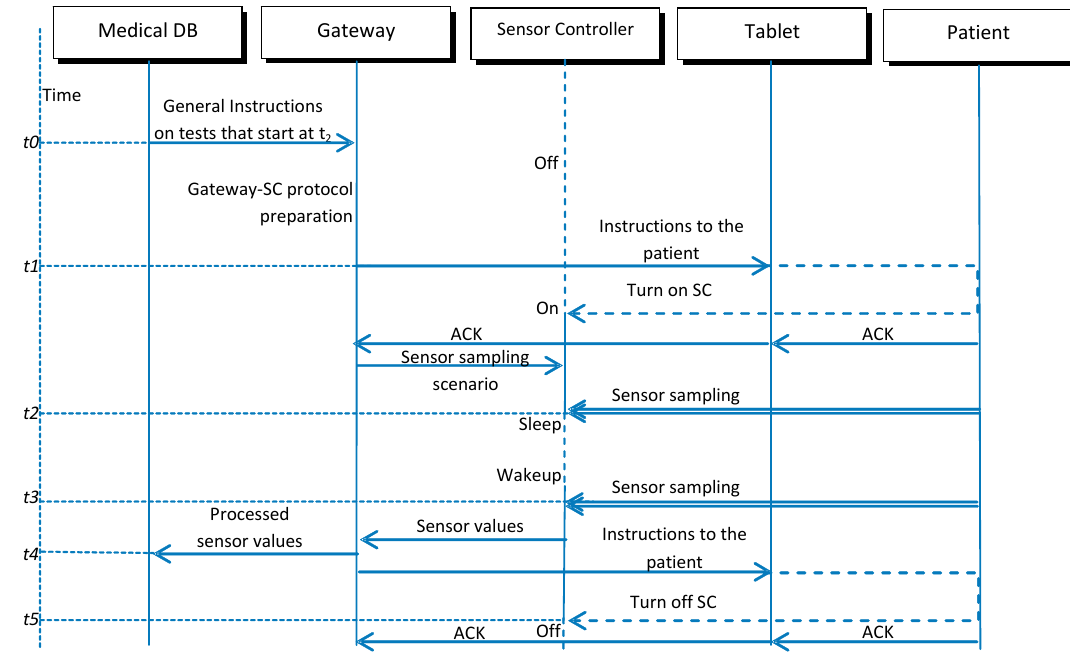
Figure 4. Typical communication scheme between the subsystems of the e- health monitoring system.